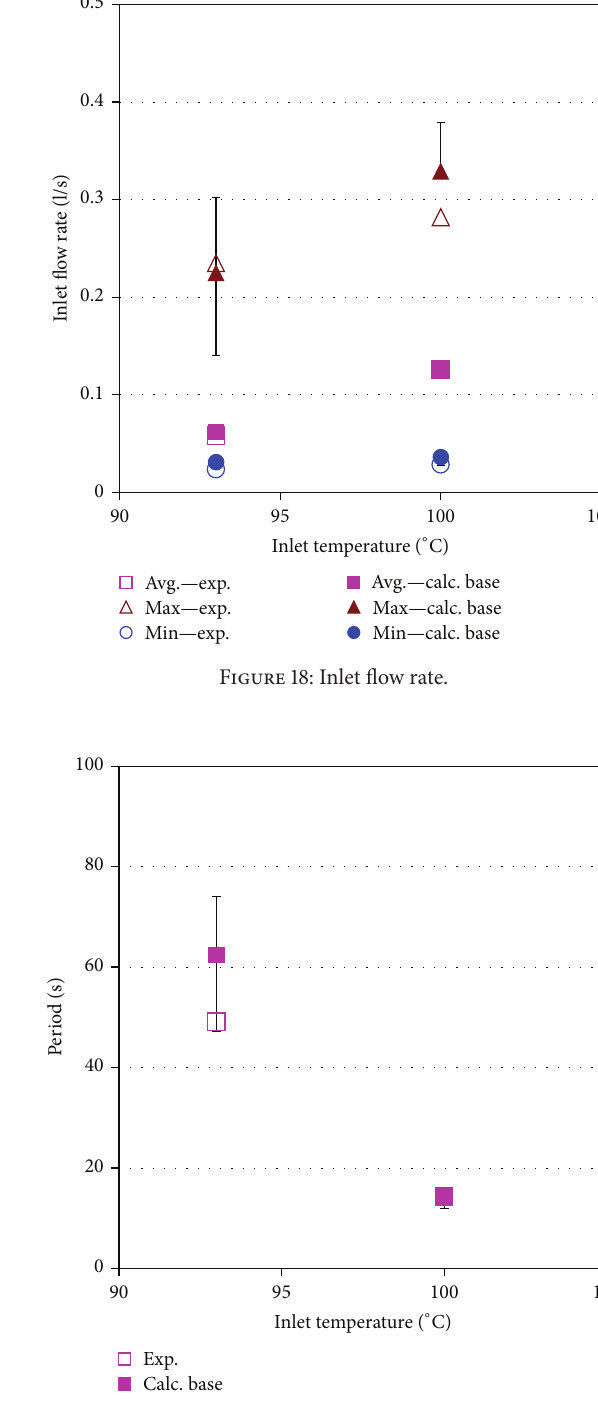
Figure 19: Oscillation